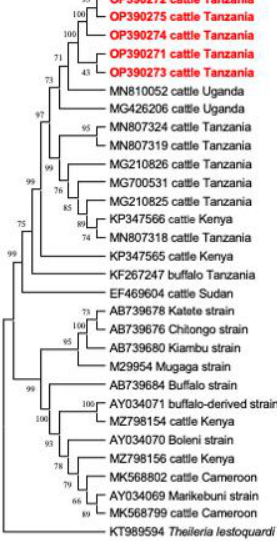
Figure 2. The phylogenetic analysis of Theileria parva identified in this study, based on the ( p104) gene sequences. The tree was constructed by MEGA version 11 using the maximum likelihood method. The numbers at nodes represent the percentage occurrence of the clade in 1000 bootstrap replications of the data. Sequences from this study are shown in red. Theileria lestoquardi (KT989594) was used as an outgroup.